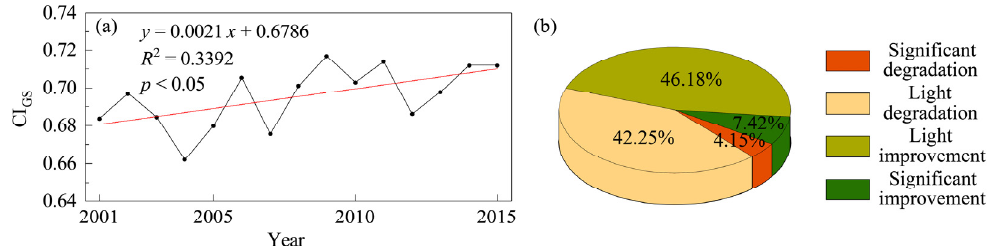
Figure 6. Interannual variations of growing season mean CI (CI GS ): ( a ) point plot of CI GS and ( b ) area proportions of the variation trend of CI GS .